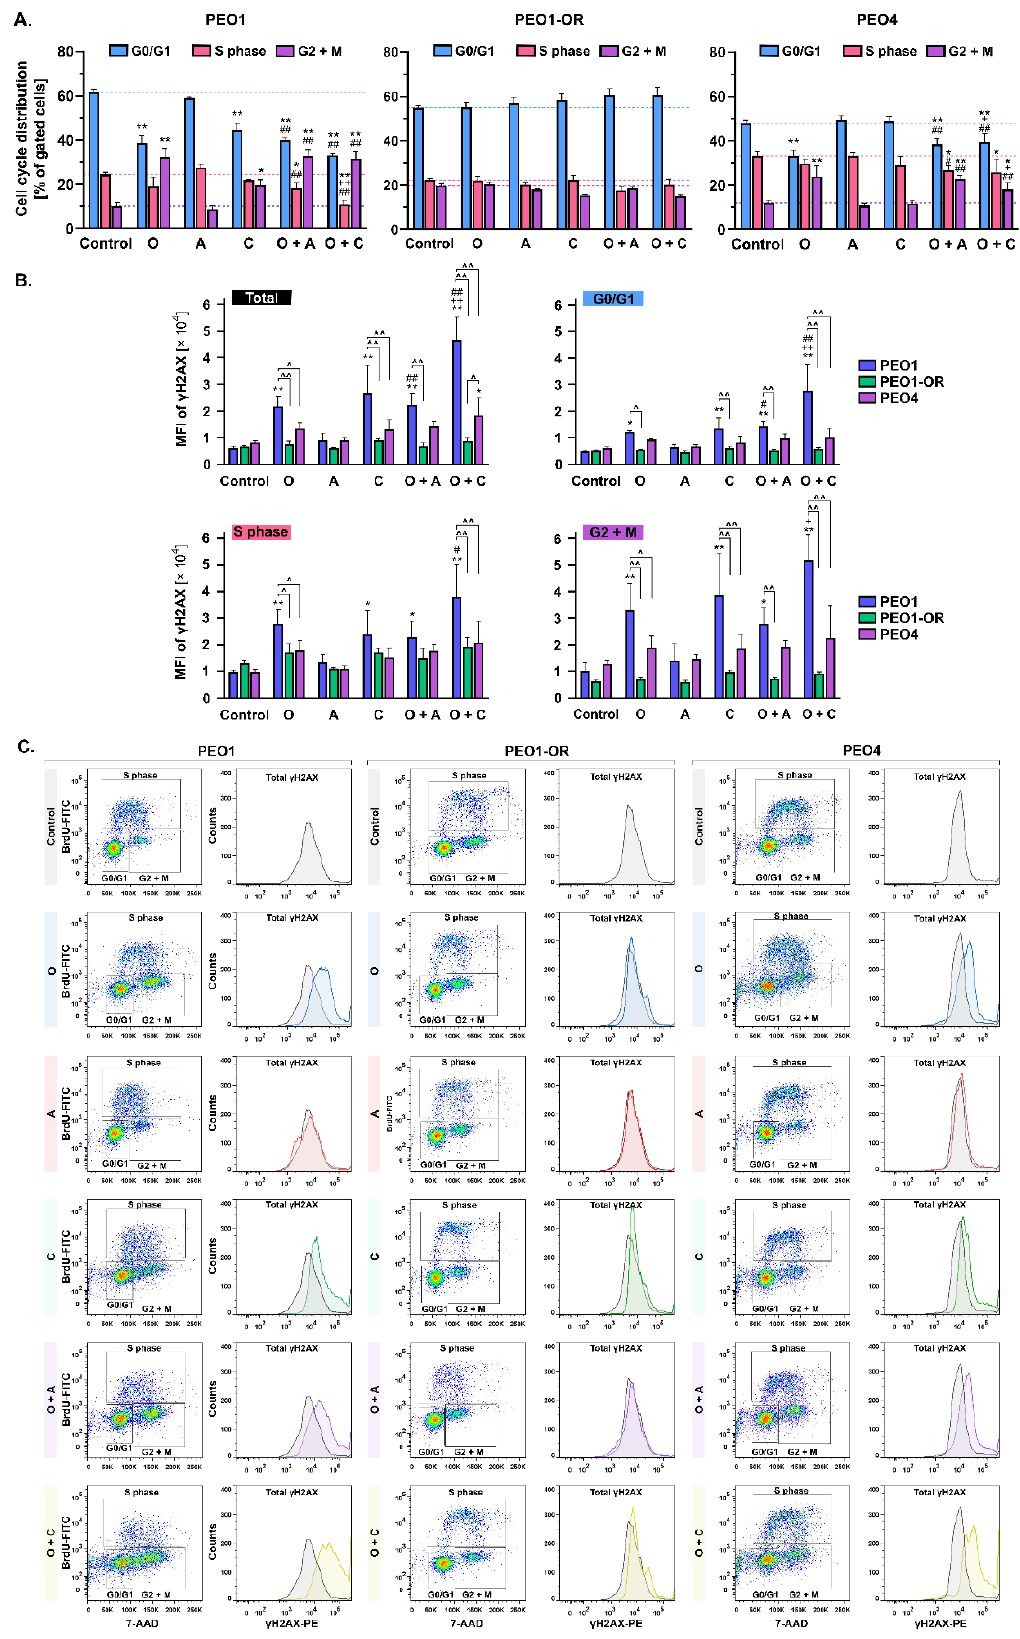
Figure 8. Effects of olaparib, ATRi, CHK1i, and their combinations on cell cycle distribution and accumulation of γH2AX depend on the sensitivity of OC cell lines to olaparib. ( A ) Cell cycle analysis with concurrent ( B ) quantitative assessment of γH2AX levels was performed via flow cytometry.